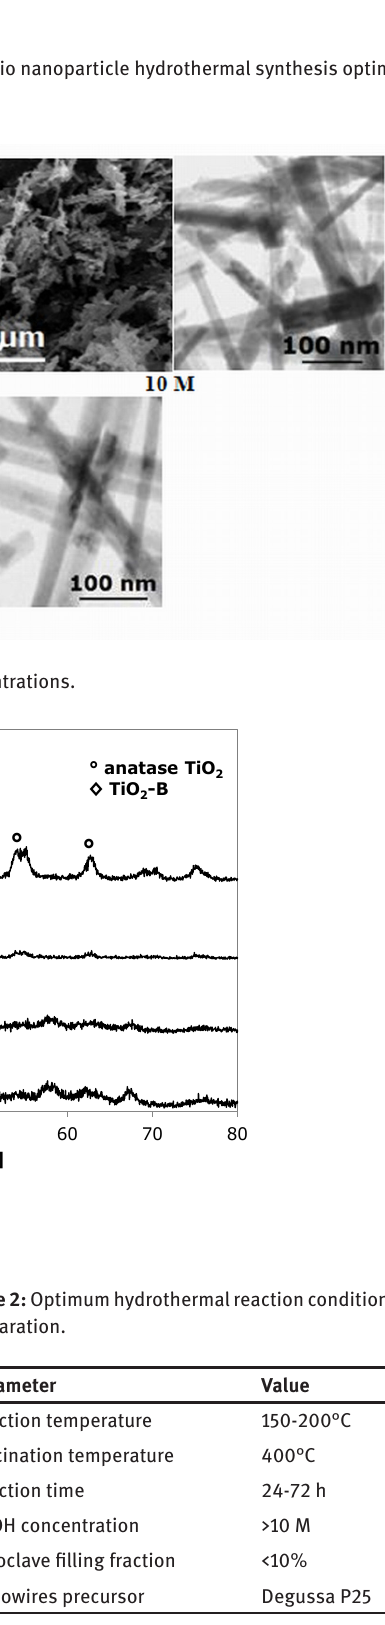
Table 2: Optimum hydrothermal reaction conditions for TiO